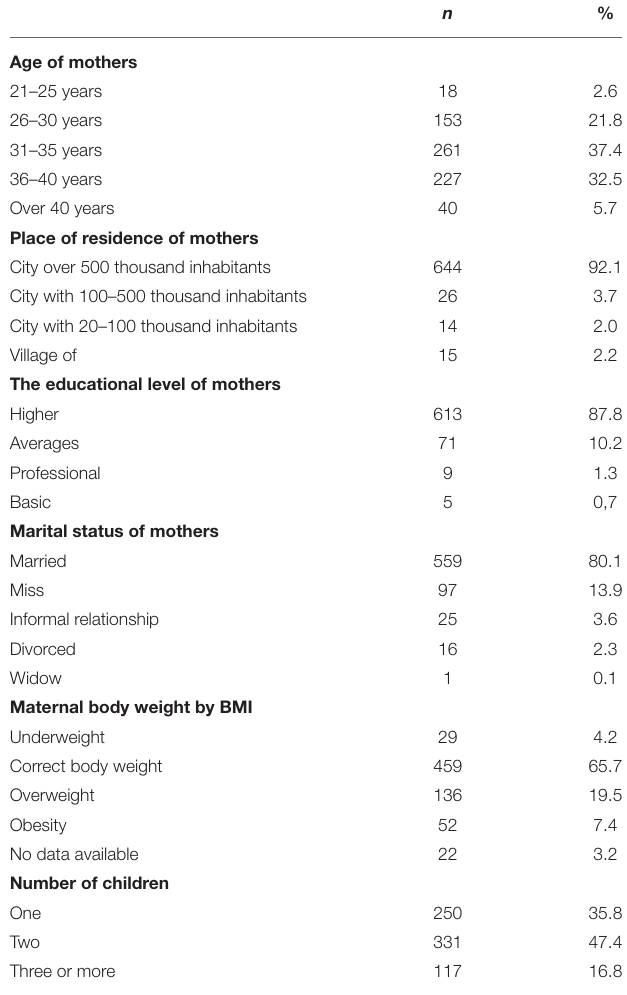
TABLE 3 | Characteristics of the study group of